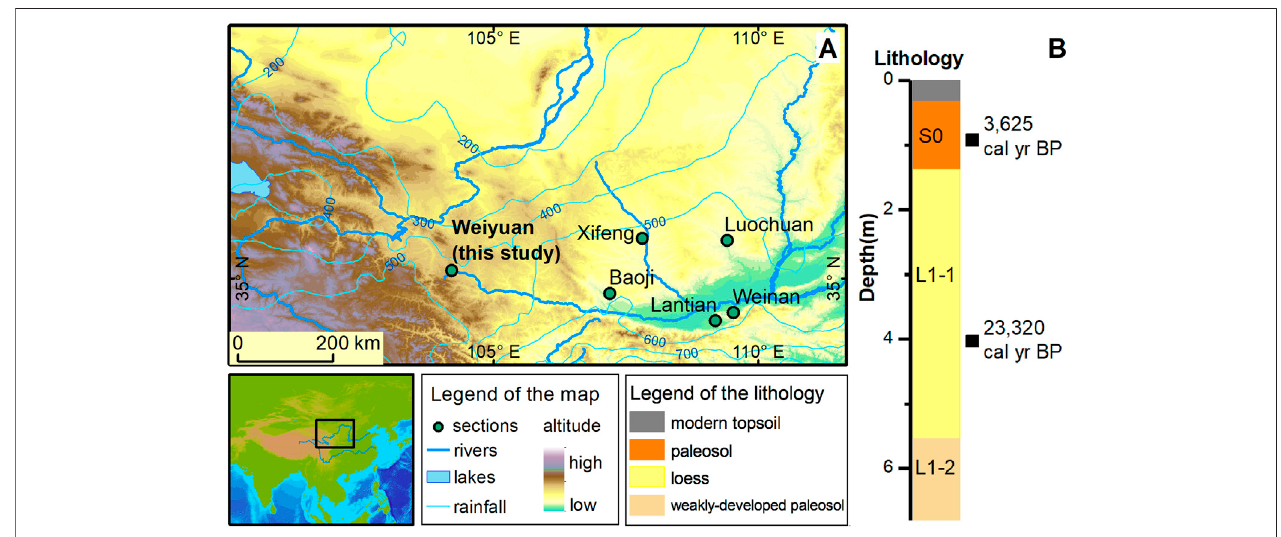
FIGURE 1 | Overview of the Weiyuan section. (A) : Location of the Weiyuan section and other sections; (B) : the stratigraphic column with the Accelerator Mass Spectrometry (AMS) radiocarbon ages of the Weiyuan section (Yang S et al., 2015).